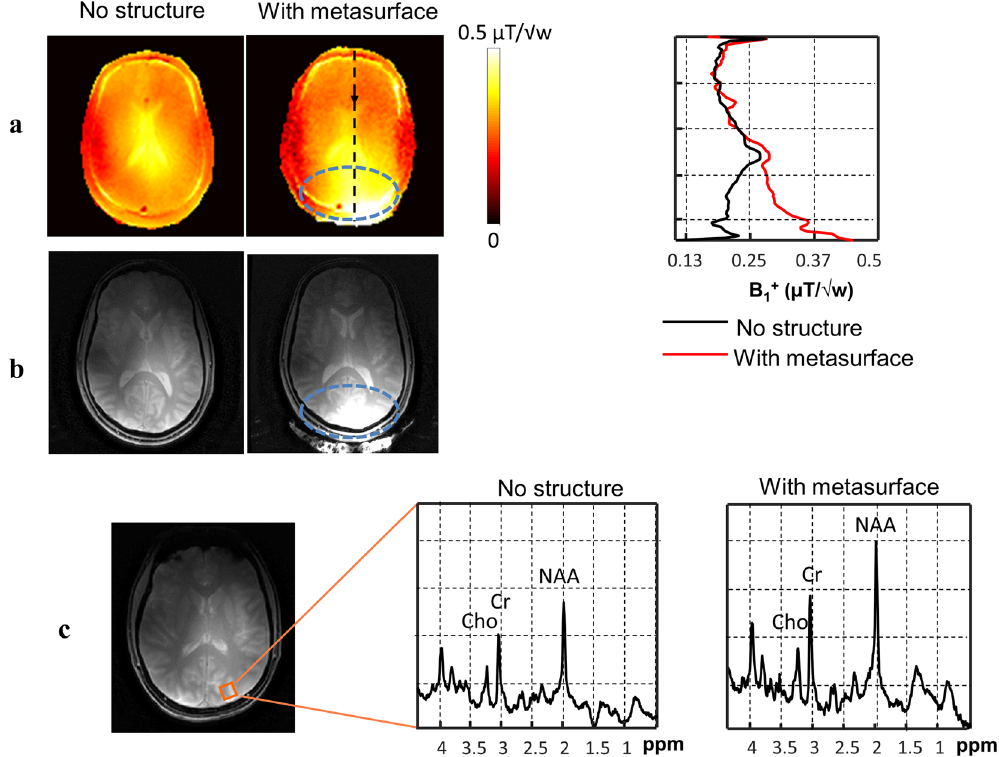
Figure 4. In-vivo imaging and spectroscopy results with and without the metasurface. ( a ) Measured RF transmit field (B 1 + ) maps and B 1 + profile along the dashed black line. ( b ) Low flip angle MR images of the brain. ( c ) Localized 1 H spectroscopy performed without (left) and with (right) the metasurface (the location of the voxel is shown by the orange overlay in the anatomic image). The intensities of the spectral plots are in arbitrary units (normalized to the root-mean-square